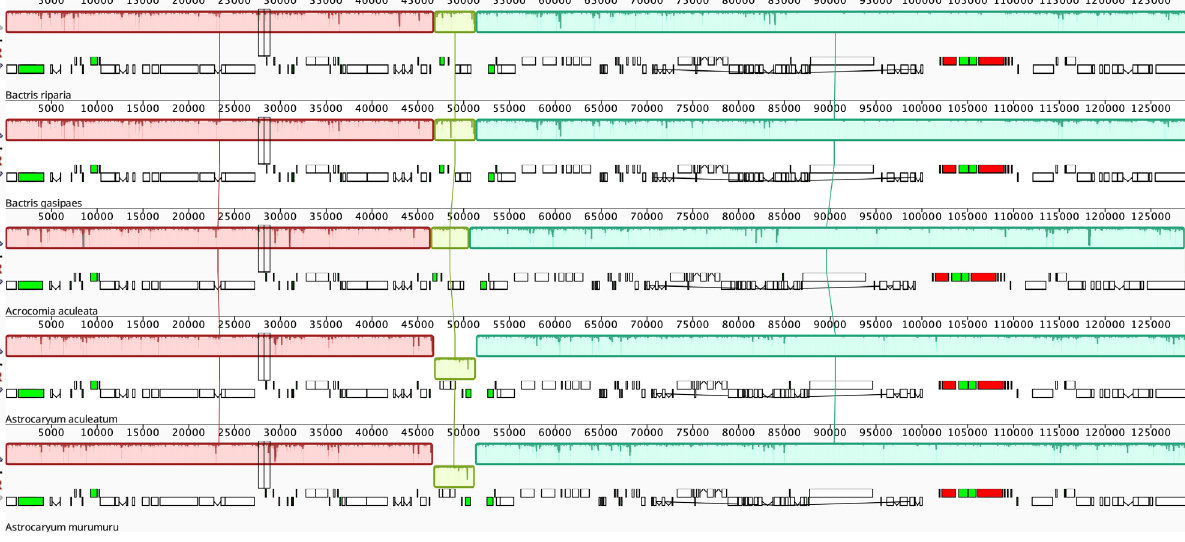
Figure 2 – Multiple alignment on Mauve comparing species of Bactridinae. Colors in the alignment represent the Locally Collinear Blocks (LCBs). Annotated genes are shown as boxes below the alignment where annotated CDS features are shown as white boxes, tRNAs are green, rRNAs are